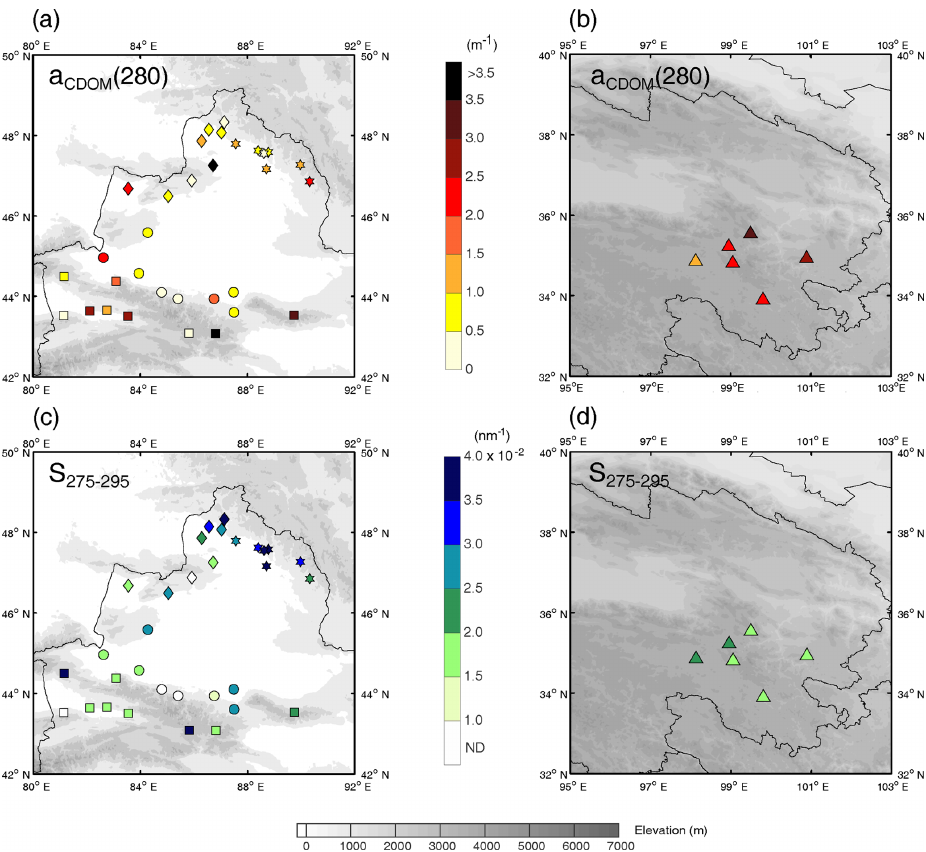
Figure 3. a CDOM ( 280 ) and S 275 − 295 for sites in (a, c) Xinjiang and (b, d) Qinghai. The five regions are indicated by different symbols (same as Fig.